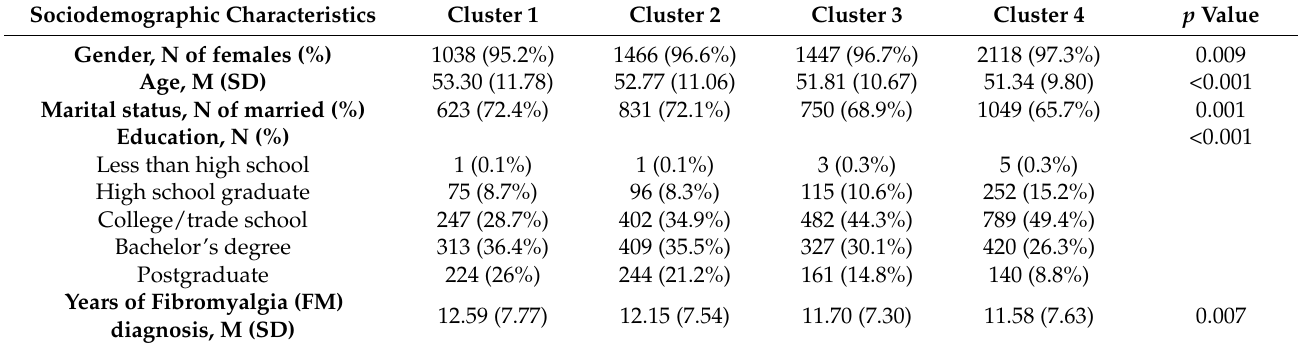
Table 1. Sociodemographic characteristics per Fibromyalgia Impact Questionnaire-Revised (FIQR) calculator-derived cluster. Sociodemographic Characteristics